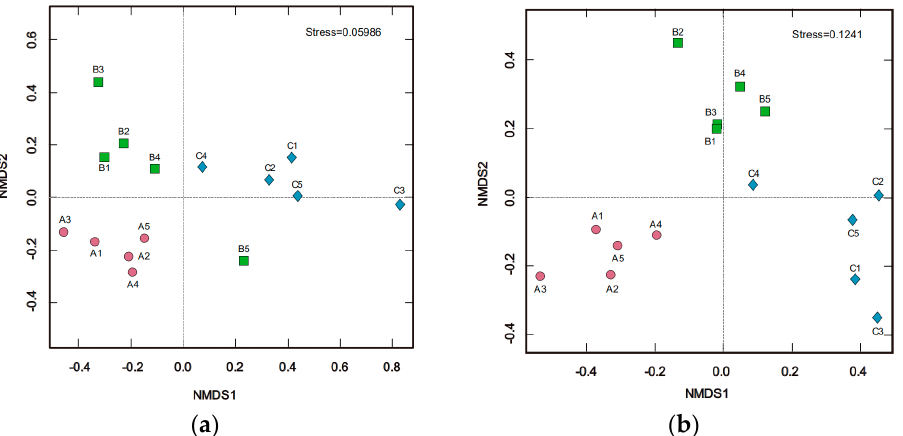
Figure 2. Nonmetric multidimensional scaling (NMDS) based on Euclidean distance plot of all soil ( a ) bacterial and ( b ) fungal communities. Red circles, green squares, and blue diamonds represent samples from sites A, B, and C, respectively. Table 4. Dissimilarity comparison of soil microbial community structure among all sampling sites.